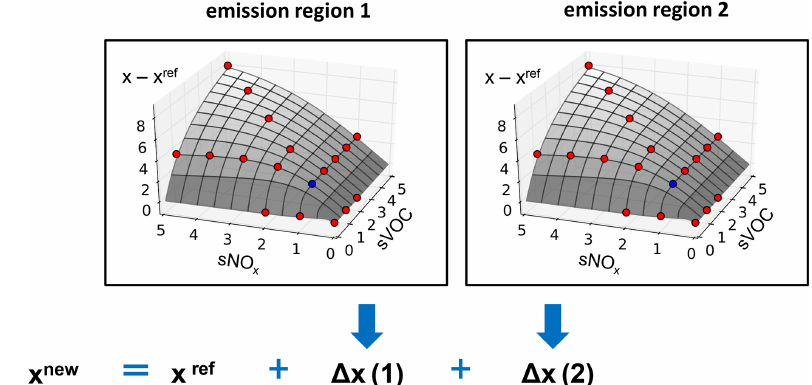
Figure 2. Schematic of interpolation algorithm used by TransClim. For each emission region, a LUT contains the change in variable x ( x − x ref ) and the emission scaling factors for NO x , VOC and CO emissions (sNO x , sVOC, sCO). In the figure, only sNO x and sVOC are displayed. The blue dot indicates the reference simulation (sNO x = 1 , sVOC = 1). The red dots indicate the emission variation simulations (note that the red dots are just a schematic and do not represent the actual emission scaling; see Table 2). After linearly interpolating within the LUT for each emission region i , the resulting changes (cid:49)x(i) are added to reference x ref . This procedure is performed for every grid box or for tropospheric or global means.